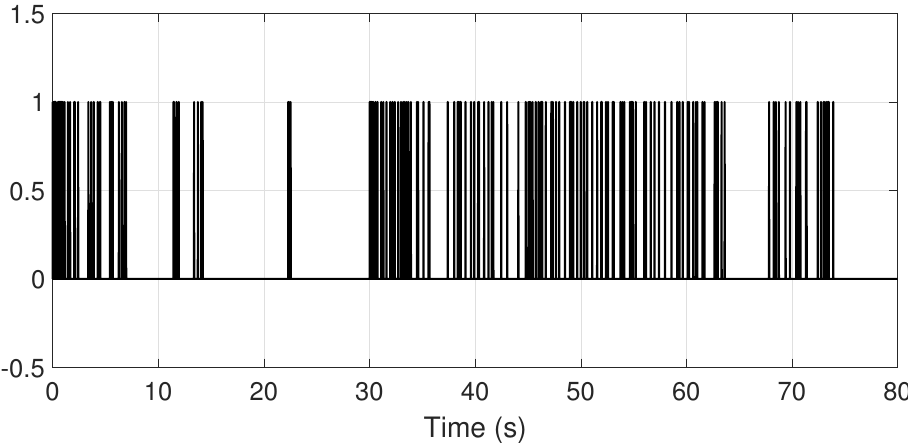
Figure 9. Numerical experiment results: sampling-instants for the noisy